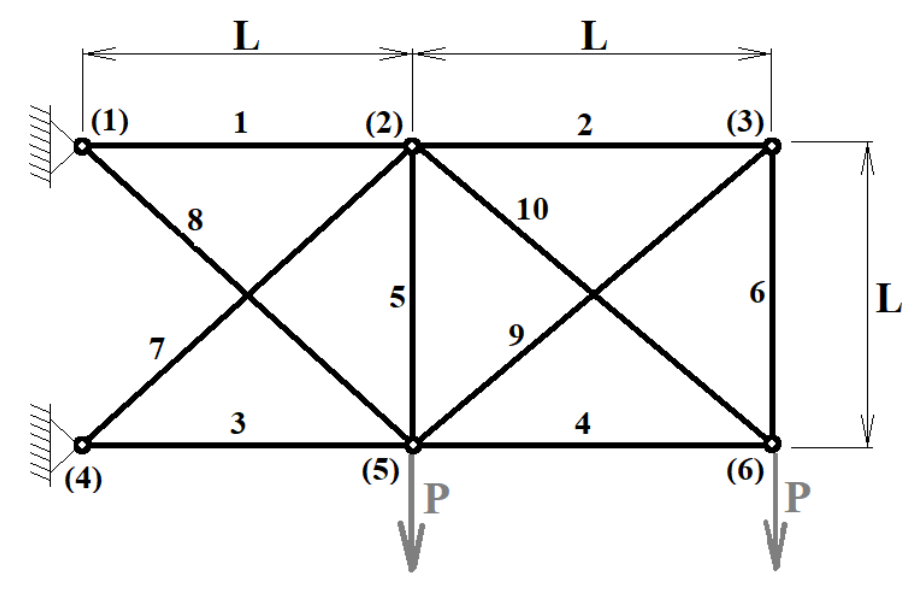
Figure 2. The truss structure for